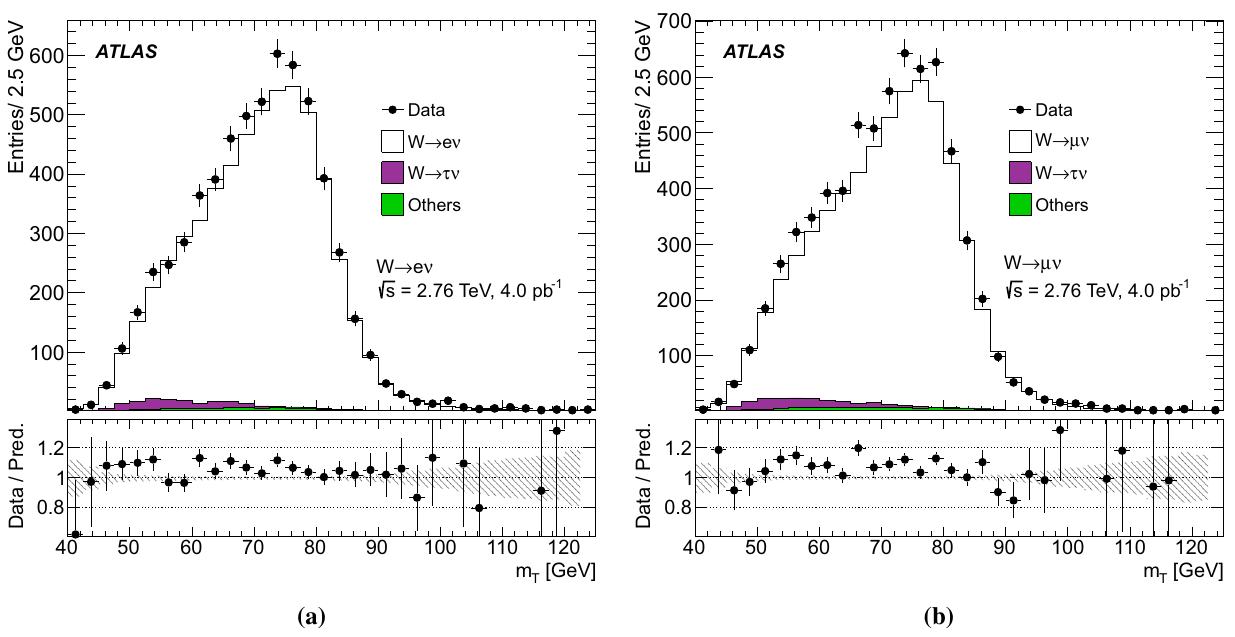
Fig. 2 The distribution of m T for W → (cid:3)ν candidate events. The expected signal, normalised to the NNLO theoretical predictions, is shown as an unfilled histogram on top of the stacked background pre- dictions. Backgrounds that do not originate from W production are grouped together into the ‘Others’ histogram. Systematic uncertainties